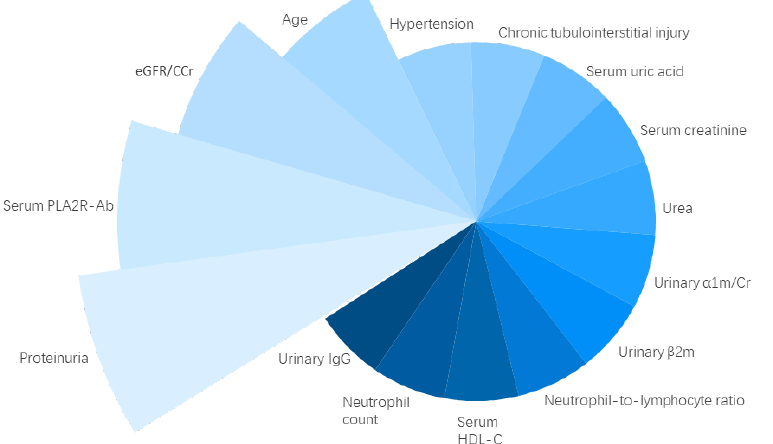
Figure 1. PRISMA flow chart.